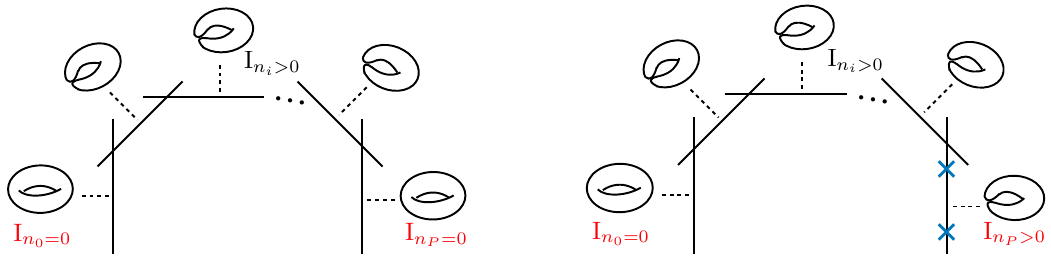
Figure 2 . The two classes of Weierstrass models underlying elliptic Kulikov Type III.a degenerations. The blue crosses denote D -type singularities in codimension